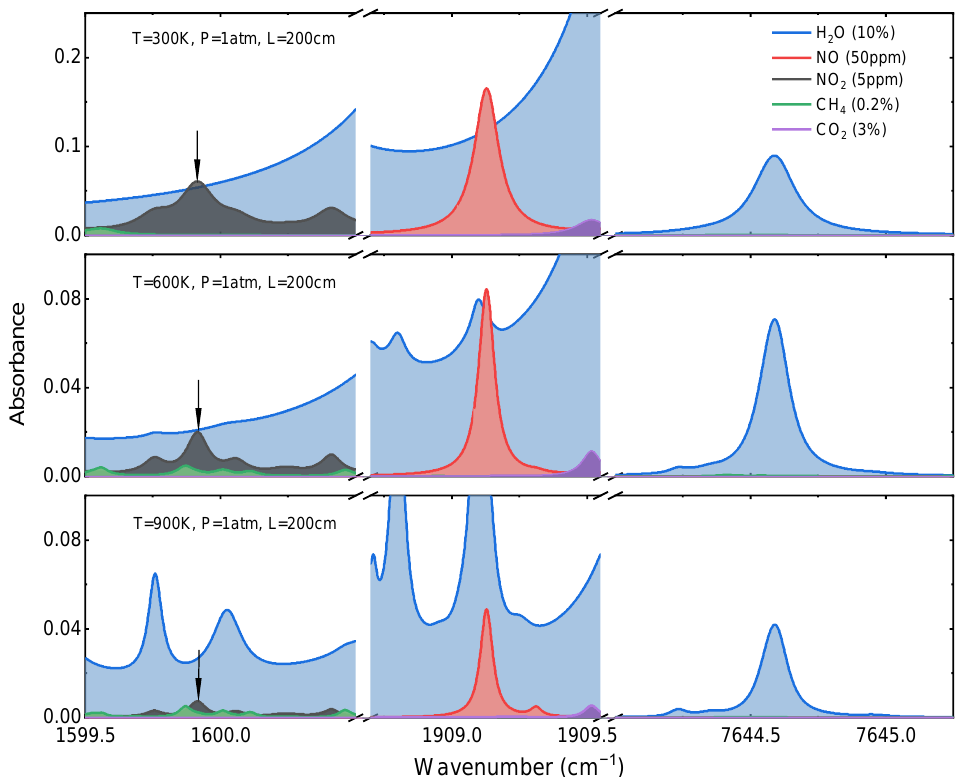
Figure 3. Simulated absorption spectra of the selected H 2 O, NO, and NO 2 transitions near 1.31, 5.2, and 6.25 µm for typical combustion exhaust: X H2O = 10%; X NO = 50 ppm; X NO2 = 10 ppm; X CH4 = 0.2%; X CO2 = 3%; P = 1 atm; L = 2 m; T = 300, 600, and 900 K.